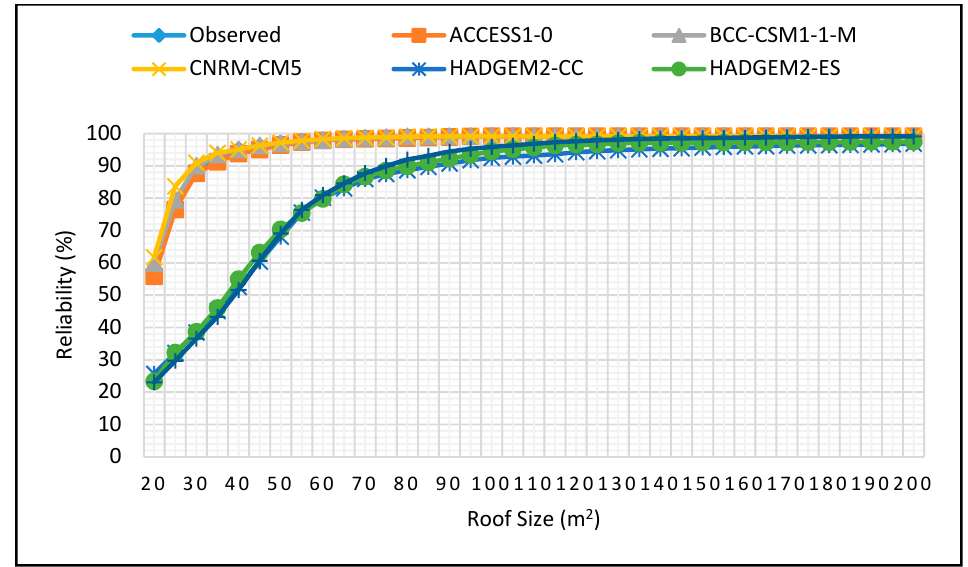
Figure 30. Reliability projections for MAM season for 5 m 3 tank size for 2060–2090 period.